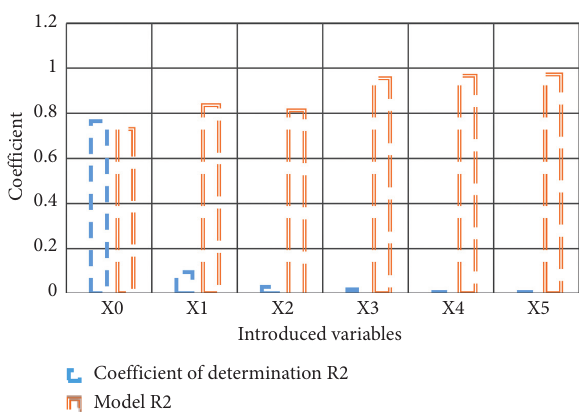
Figure 4: Stepwise regression coefficient of regression